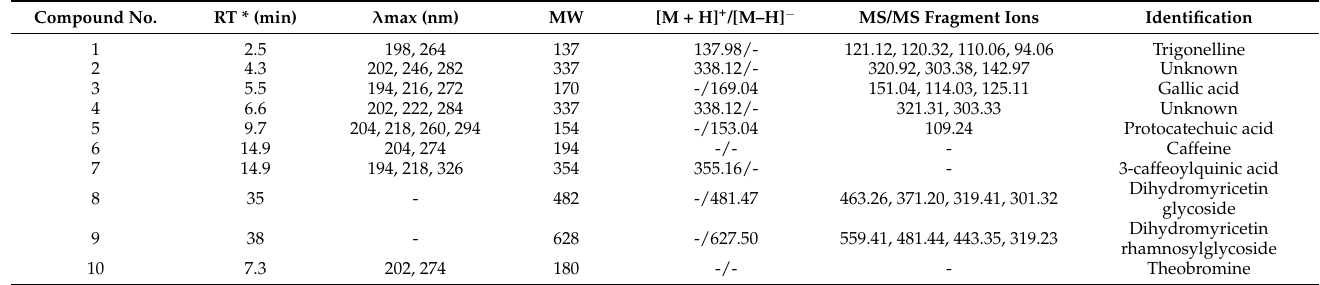
Table 3. Identification of the 10 compounds in CP samples by HPLC, MS and MS/MS.